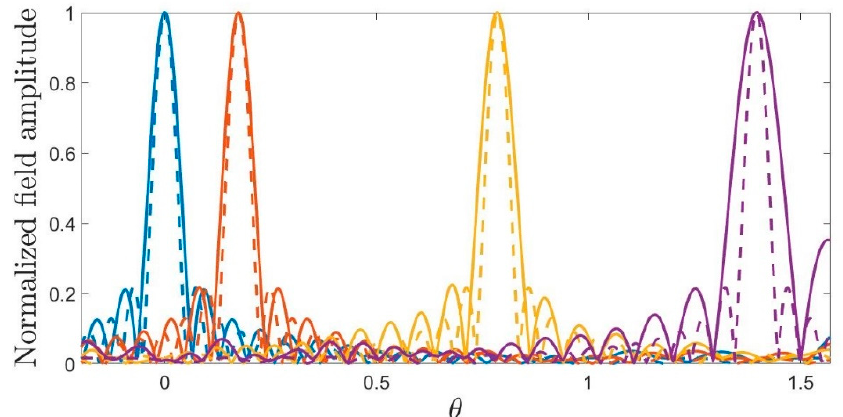
Figure 18. Normalized field amplitude of the desired field E ( θ ) (dashed curves) and the projected field